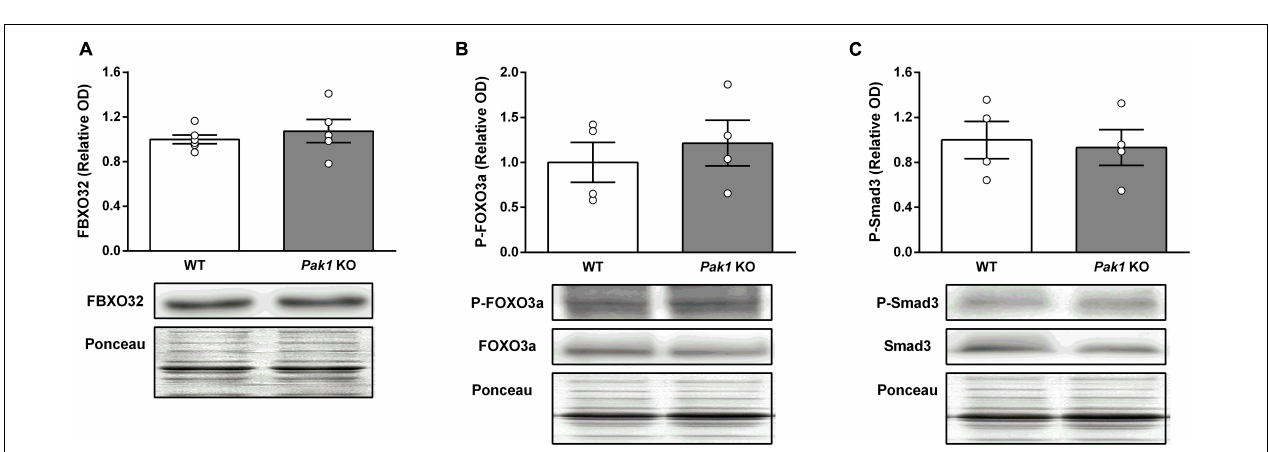
FIGURE 6 | Pak1 deletion tends to increase the sActRIIB-induced 4E-BP1 inactivating phosphorylation. (A) Representative western blot images and densitometric analysis of (B) P-AKT, (C) P-S6, (D) P-P70S6K, and (E) P-4E-BP1 levels in GC muscles from Pak1 KO and WT mice after 2 injections of sActRIIB (green columns) or PBS (white columns) ( n = 4/group). The results are expressed as mean ± SEM. Statistical analysis was performed using two-way ANOVA tests (sActRIIB effect: # P < 0.05 and ## P < 0.01) and Bonferroni post-tests (sActRIIB effect: * P < 0.05).